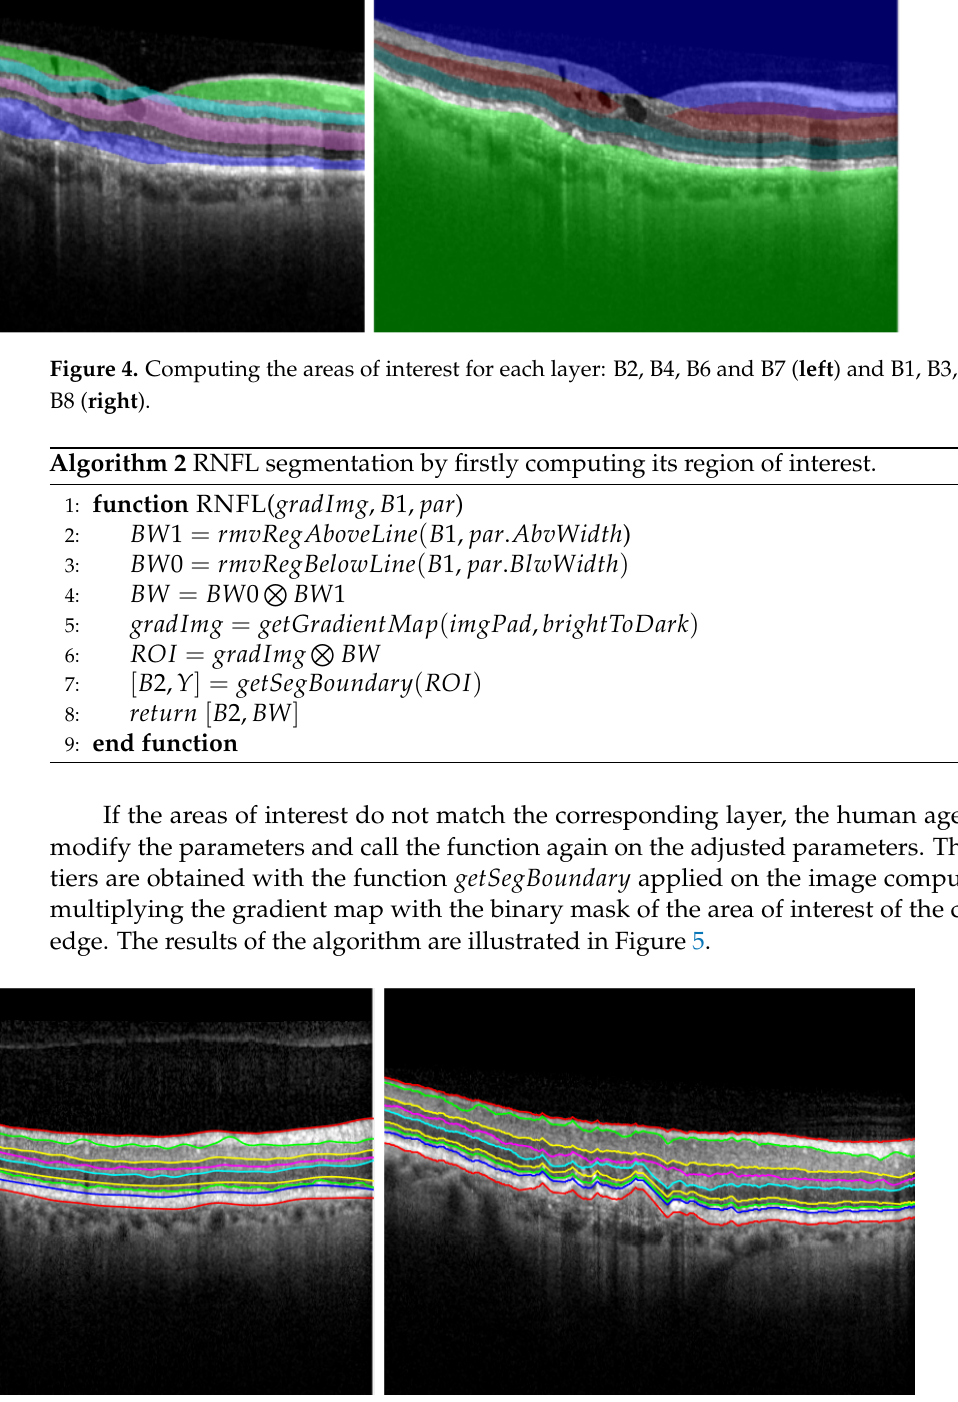
Figure 5. Retinal segmentation on a healthy retina on the left side, while segmentation of a pathologi- cal retina is presented on the